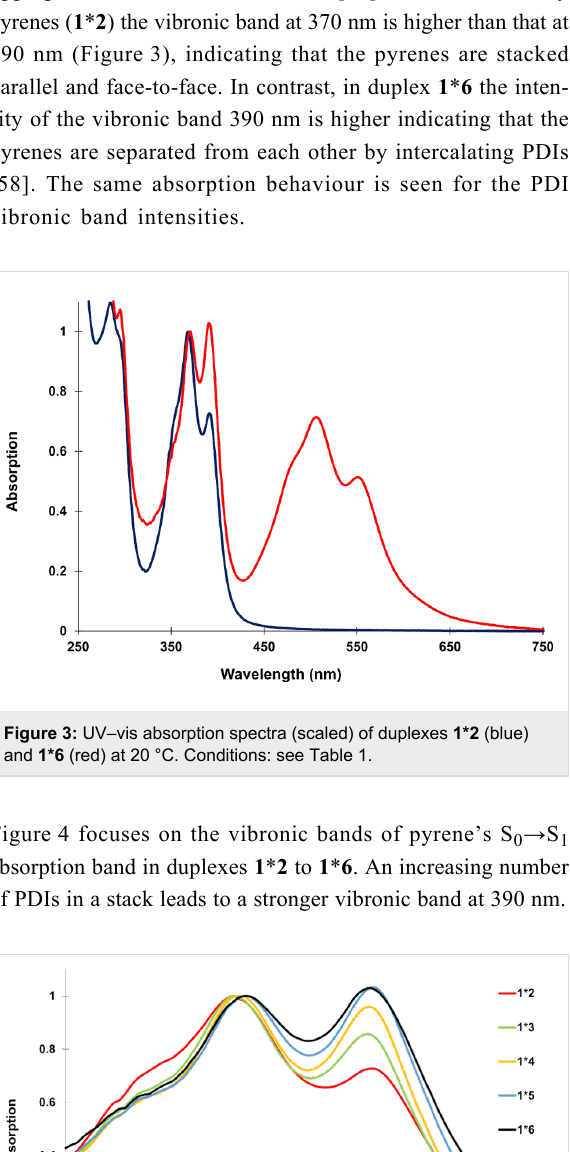
Figure 4: UV–vis absorption spectra (scaled) of duplexes 1 * 2 to 1 * 6 at 20 °C. Conditions: see Table 1.